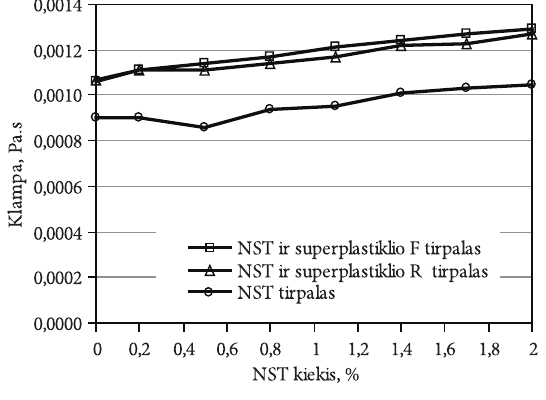
Fig. 2. Dependence of water dispersion viscosity on NSS % content in the